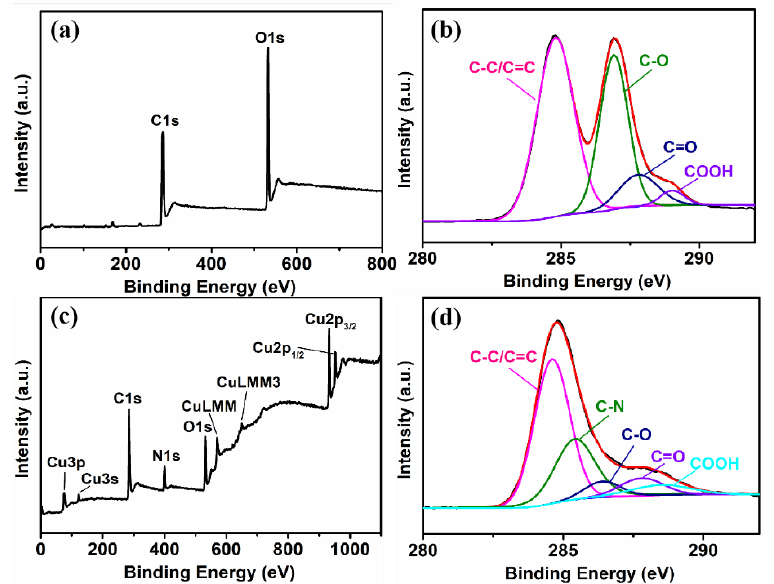
Figure 8. XPS spectra of rGO/PPy/Cu 2 O nanocomposite before and after high-temperature thermal reduction: ( a ) wide-range and ( b ) high-resolution C 1s XPS spectra of GO, and ( c ) wide-range and ( d ) high-resolution C 1s XPS spectra of rGO/PPy/Cu 2 O nanocomposites.